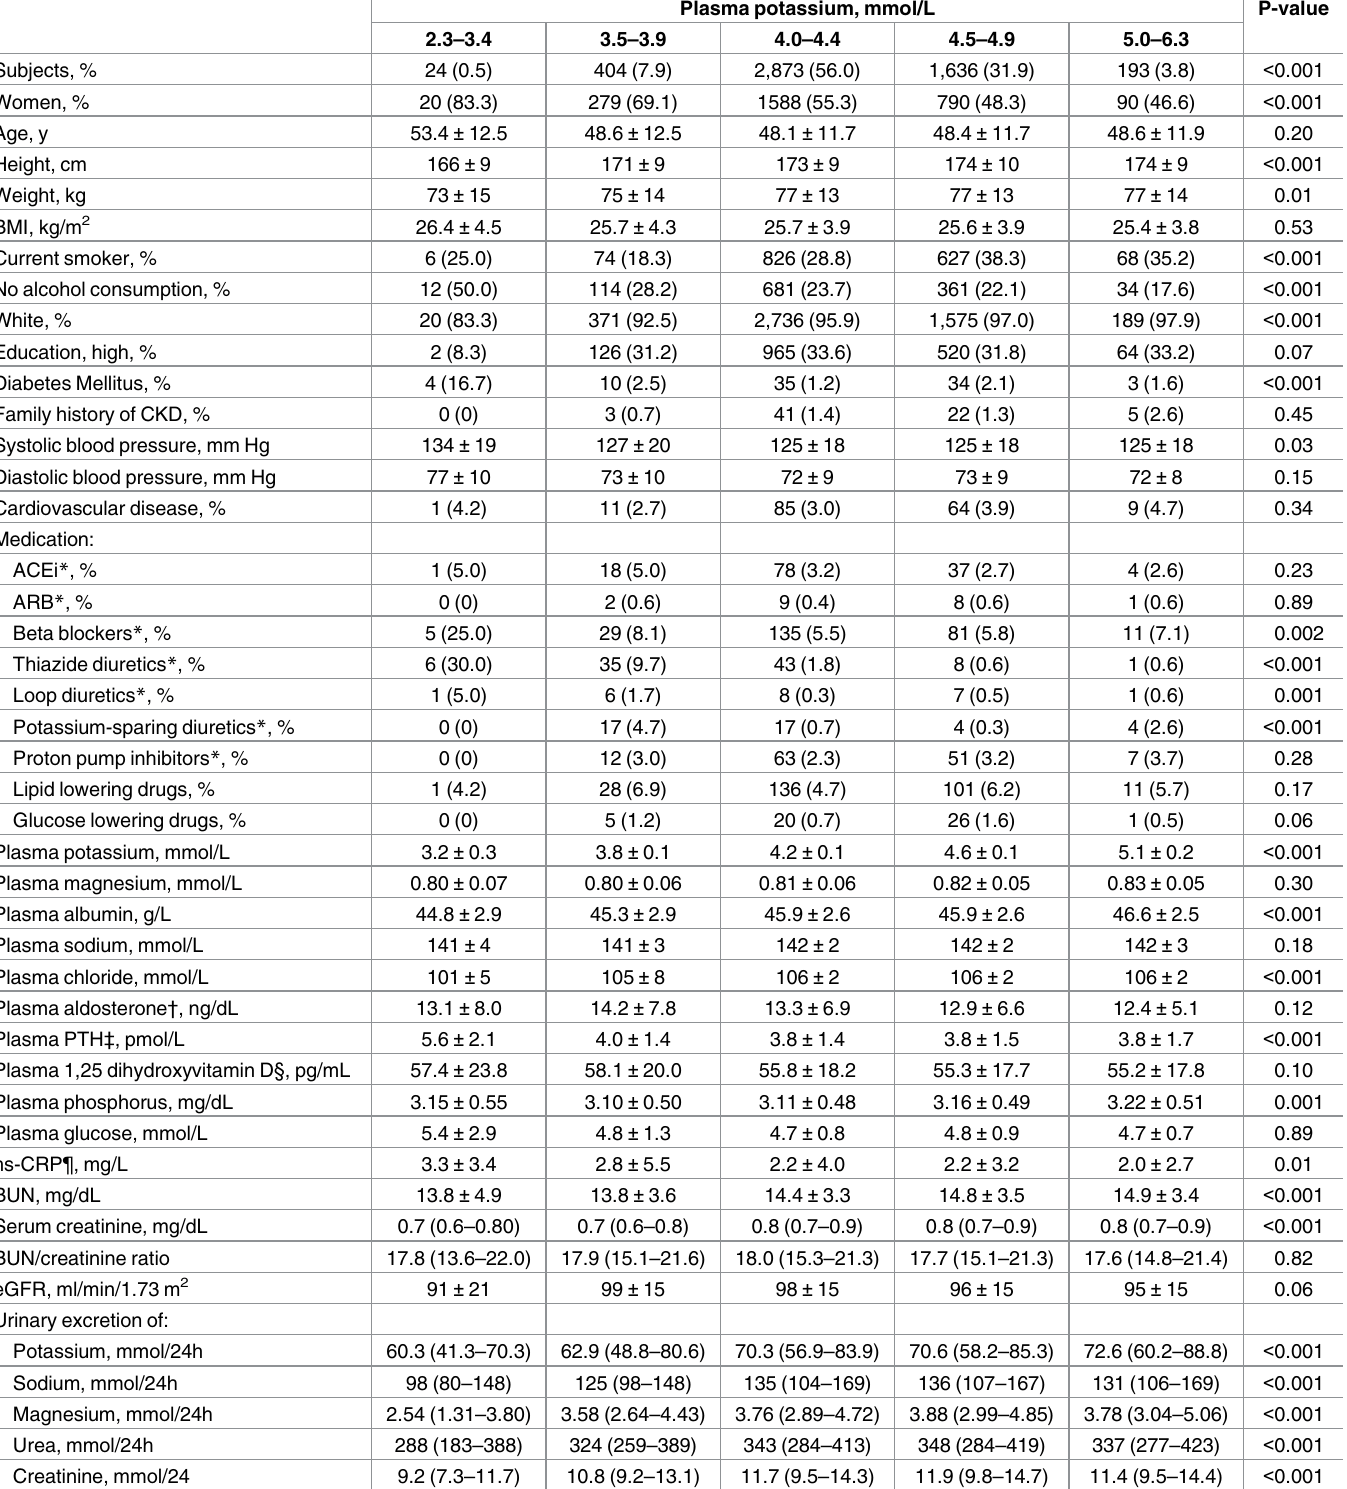
Table 1. Baseline characteristics of the 5,130 participants of the Prevention of Renal and Vascular End-Stage Disease(PREVEND)